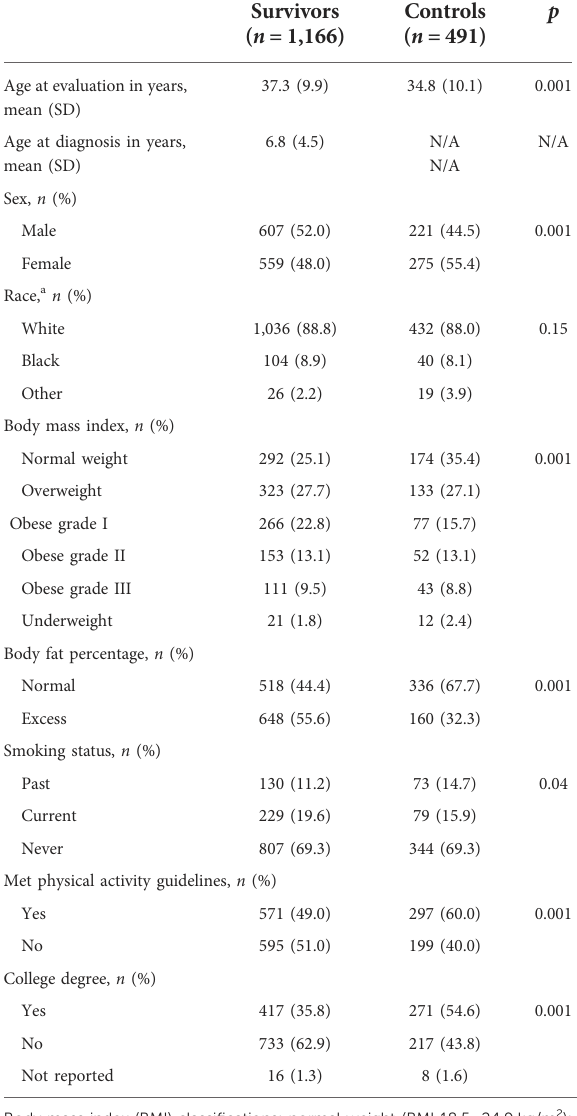
TABLE 1 Demographic characteristics of acute lymphoblastic leukemia survivors and the community controls.